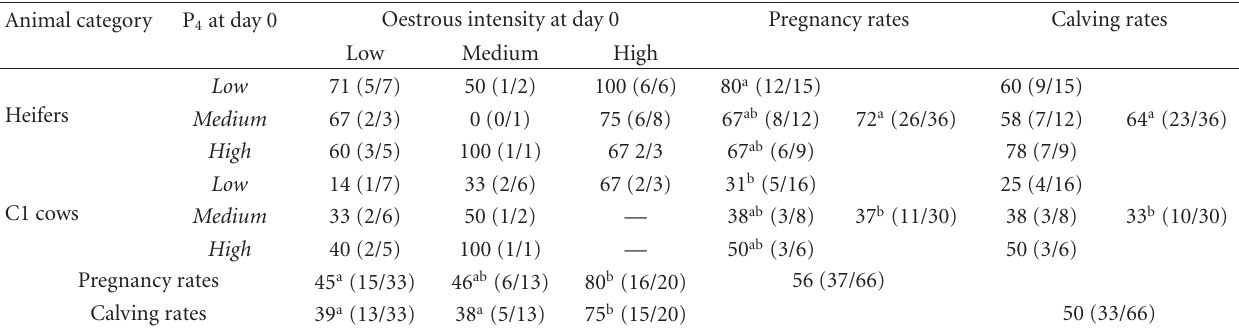
Table 3: Percentages of pregnancy (animal ratios in parentheses) at day 50 (transrectal manual examination) and of calving, disclosed by relative P 4 level in blood serum on day 0 and by intensity of oestrus (day 0) for dairy Heifers ( n = 37) or first parity cows (C1 cows, n = 30). Animal category P 4 at day